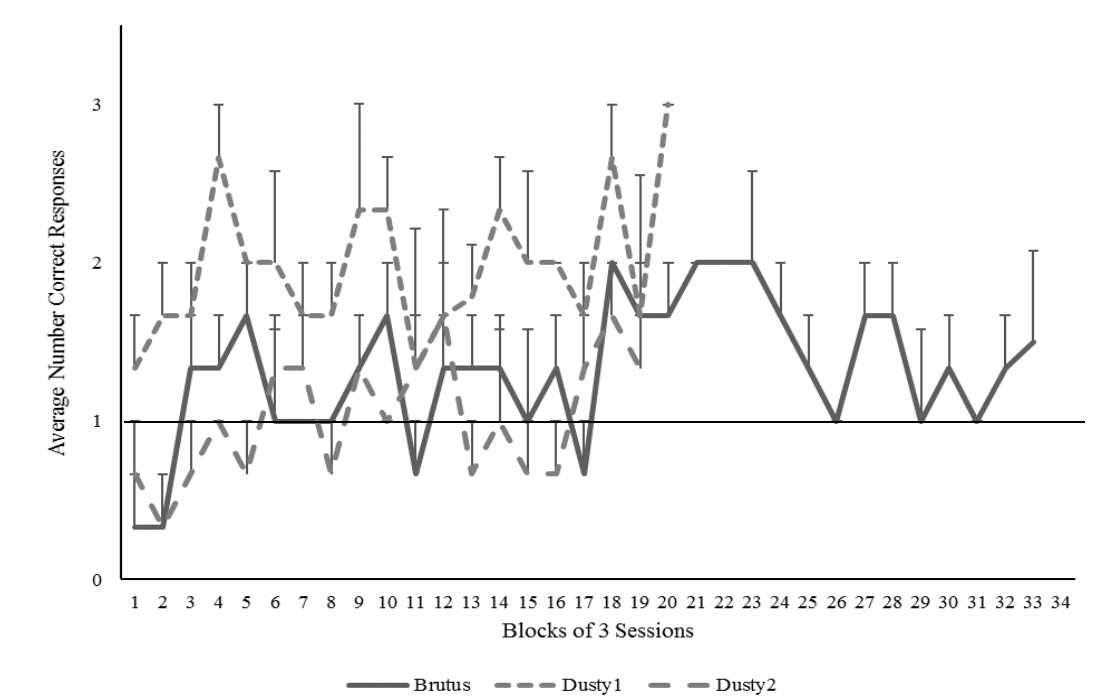
Figure 2 . Average number of correct responses across blocks of three sessions with standard error bars representing standard error of the mean. The line at 1 indicates chance